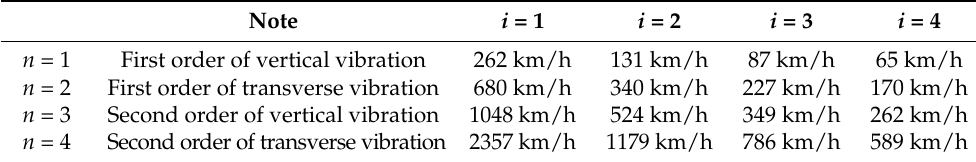
Table 4. Theoretical resonance velocity of each order of bridge with span of 30 m.